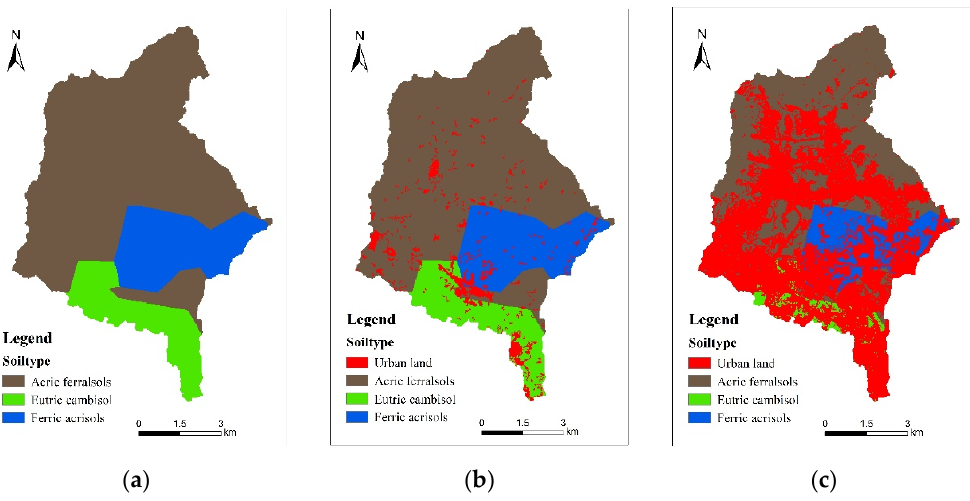
Figure 5. Soil map of the Chebei Creek watershed: ( a ) 1987 soil type map from the FAO dataset; ( b ) updated 1987 soil type map with estimated LUC; ( c ) 2015 soil type map with estimated